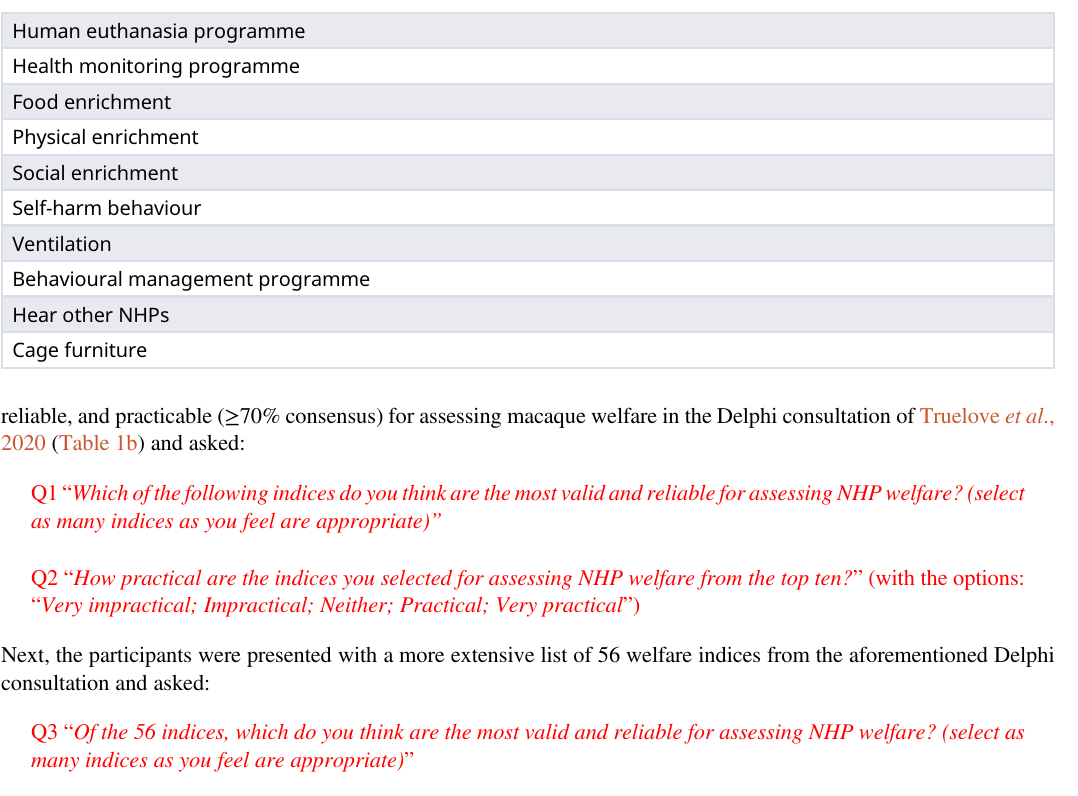
Table 1b. Top ten indicators from Truelove et al .